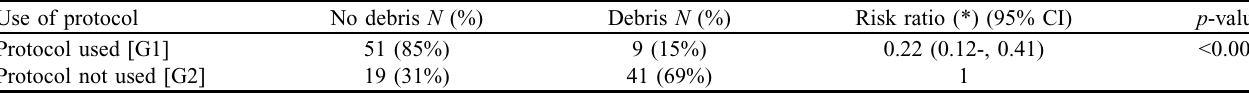
Table 2. Comparison between patients who showed debris and those who did not in post-operative radiographs among the two groups. Use of